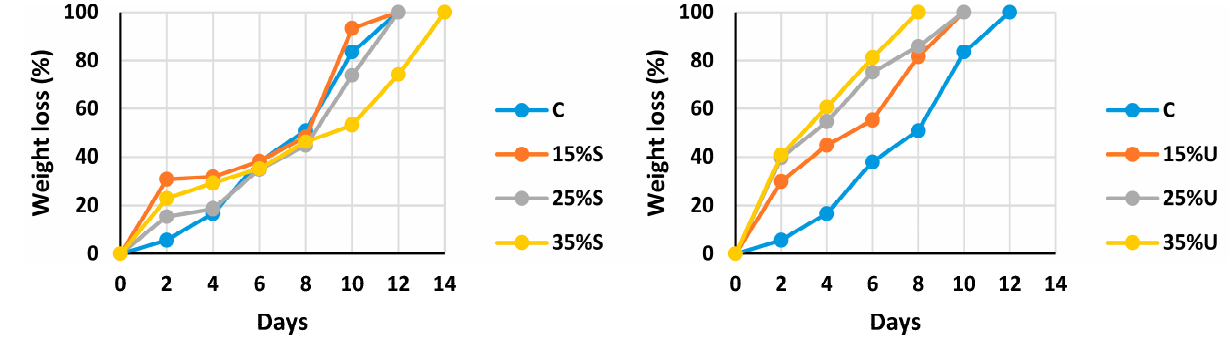
Figure 3. Degradation of wheat starch films with various plasticizer types at different concentra- tions.